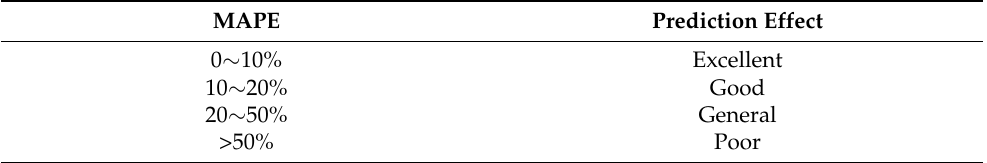
Table 4. The model evaluated classification of MAPE value.